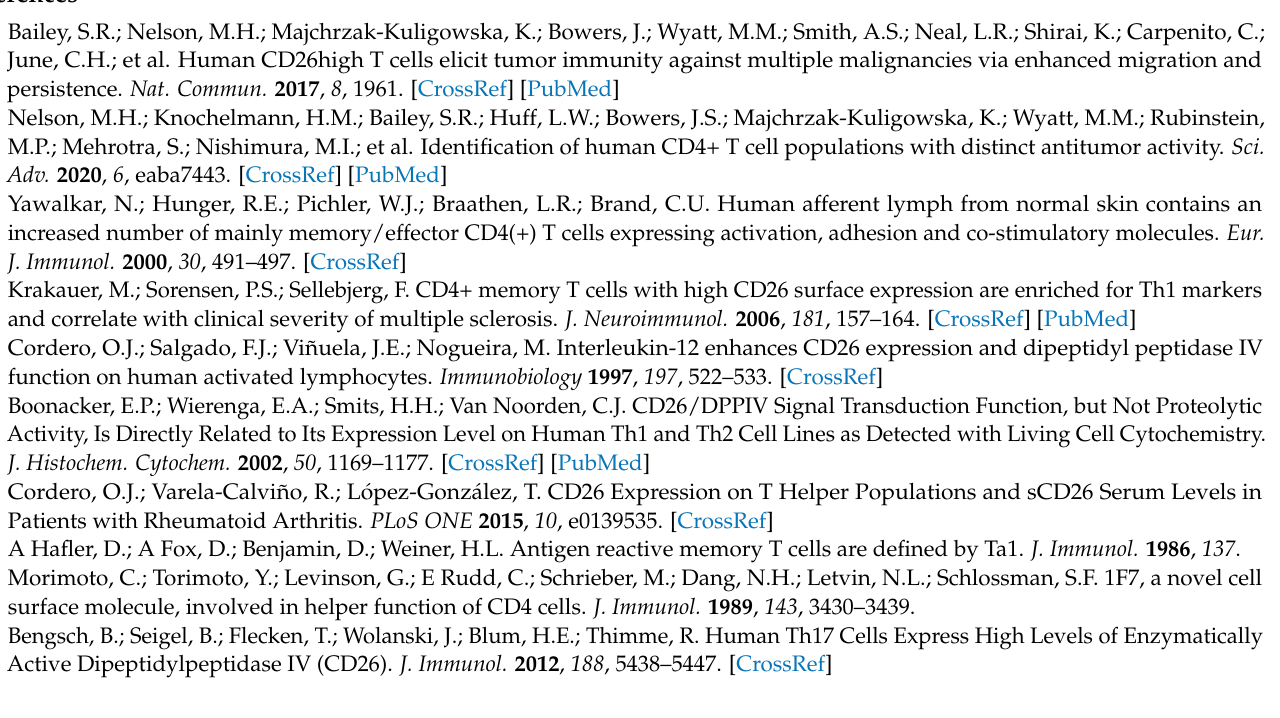
Figure S3: Surface CCR7, CD62L and CD27 positivity frequencies in the major CD4 + T cell subsets defined by surface CD45R0 and CD26 expression. Figure S4: Surface CD25 expression to define T reg subsets defined by CD26 expression. Figure S5: Surface CXCR5, CCR4, CXCR3 and CCR5 positivity frequencies in the major CD4 + T cell subsets defined by surface CD45R0 and CD26 expression. Figure S6: Gating strategy for lymphocytes after the in-vitro activation in polarizing or not conditions. Figure S7: Intracellular CD26 expression in CD45R0+ CD4 T cells (blasts) activated in vitro under different polarization